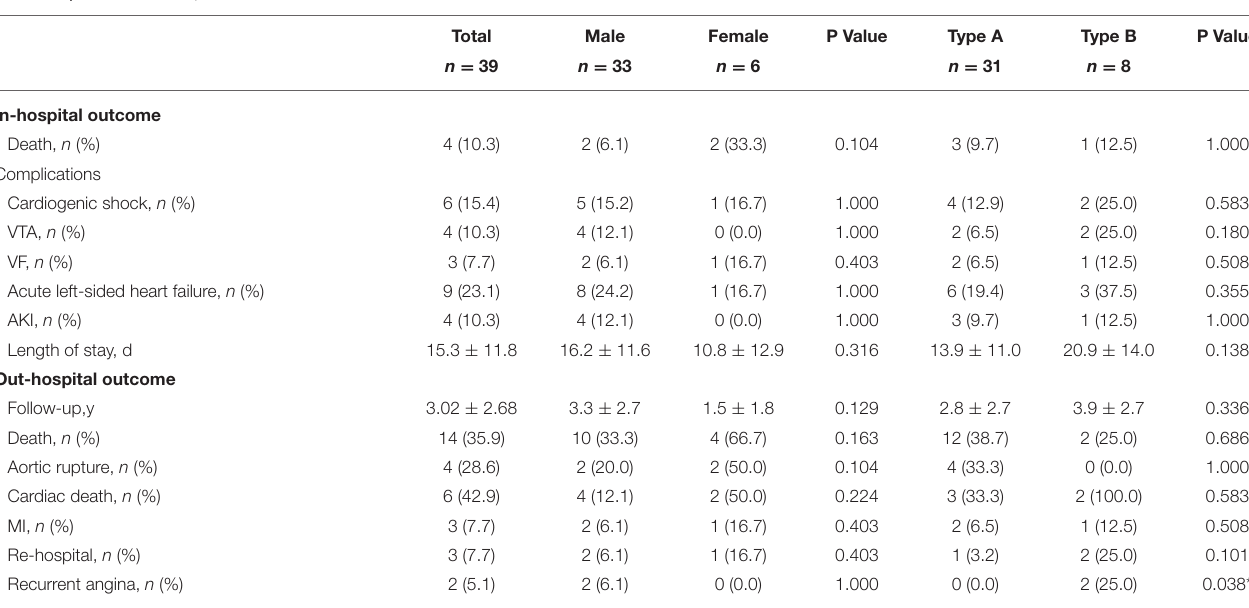
TABLE 4 | In- and out-hospital